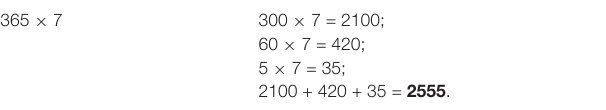
TABLE 2 | Example for multiplication using decomposition strategies. 365 × 7